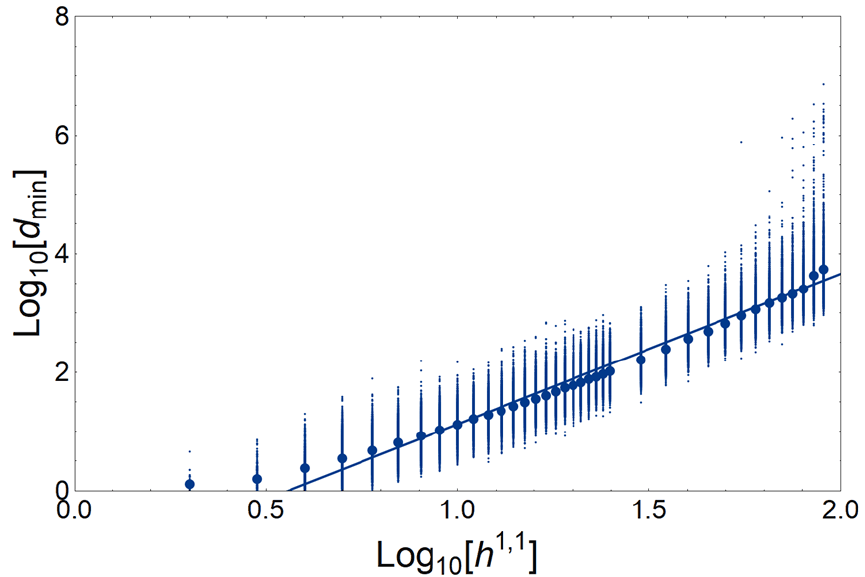
Figure 5. log 2 : 5 log ( h 1 ; 1 10